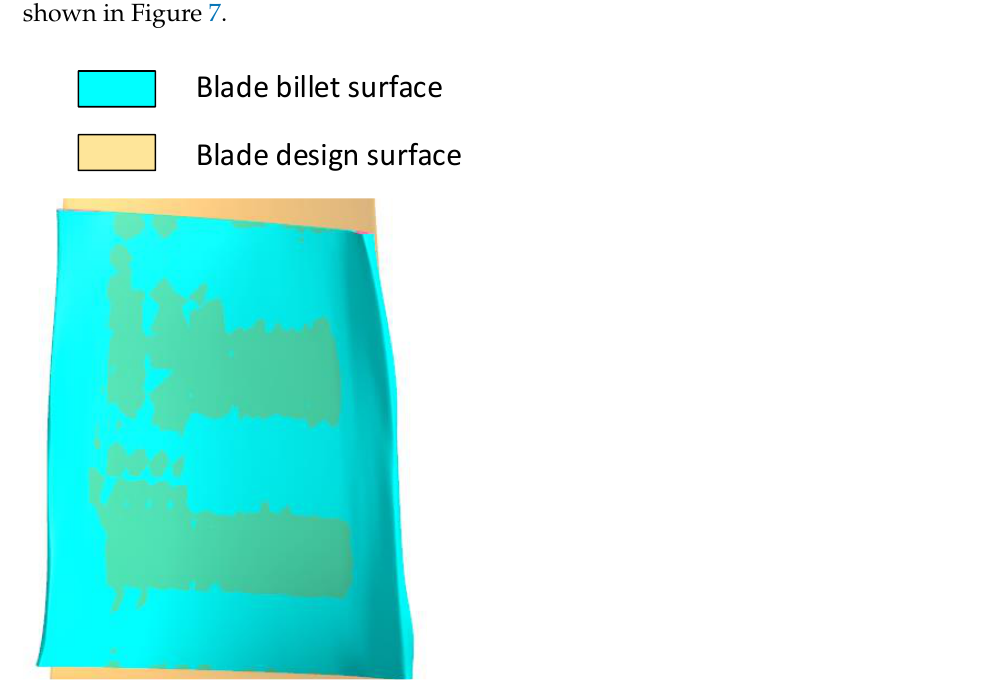
Figure 7. The design blade model and the blade billet surface constructed by the measured points.